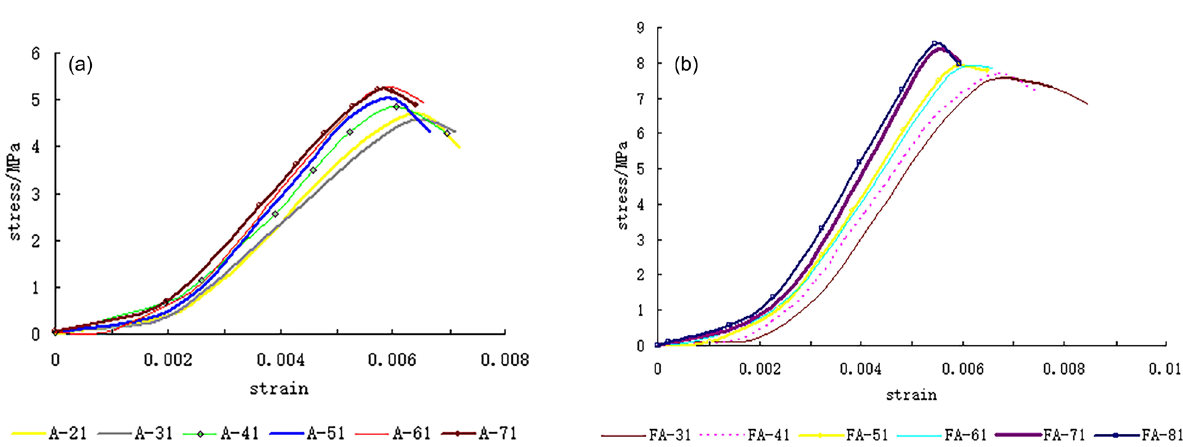
Figure 12. Stress–strain curves of ( a ) type I and ( b ) type II composite rock